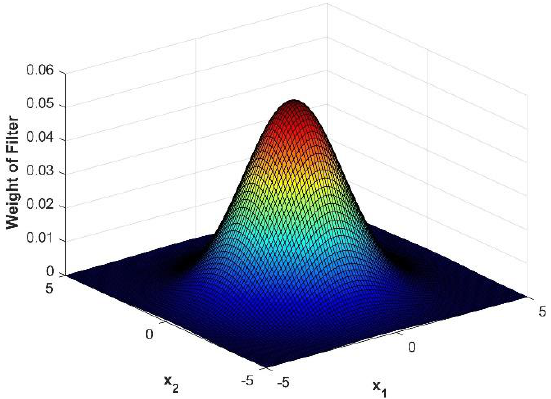
Figure 5. Visual representation of the weights of the gaussian filter with a step size of 5 and standard deviation of 5/3.